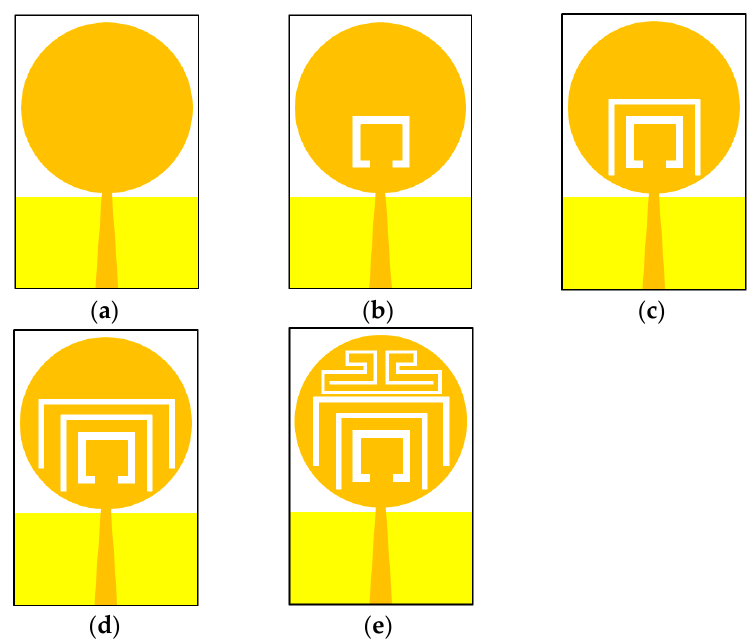
Figure 2. Design steps of the proposed quad band-notched SWB antenna: ( a ) Antenna-1; ( b ) Antenna-2; ( c ) Antenna-3; ( d ) Antenna-4; ( e ) Antenna-5.